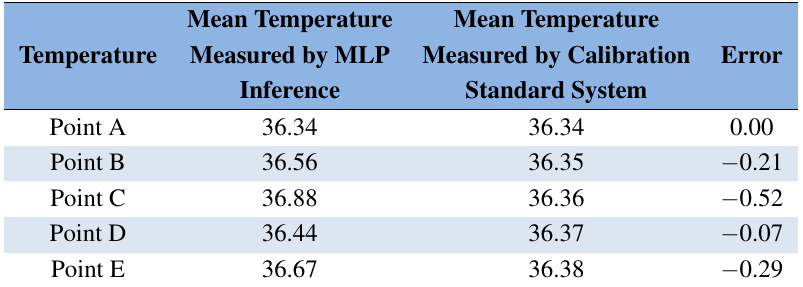
Table 5. Calibration results using the proposed system; control temperature = 36 ◦